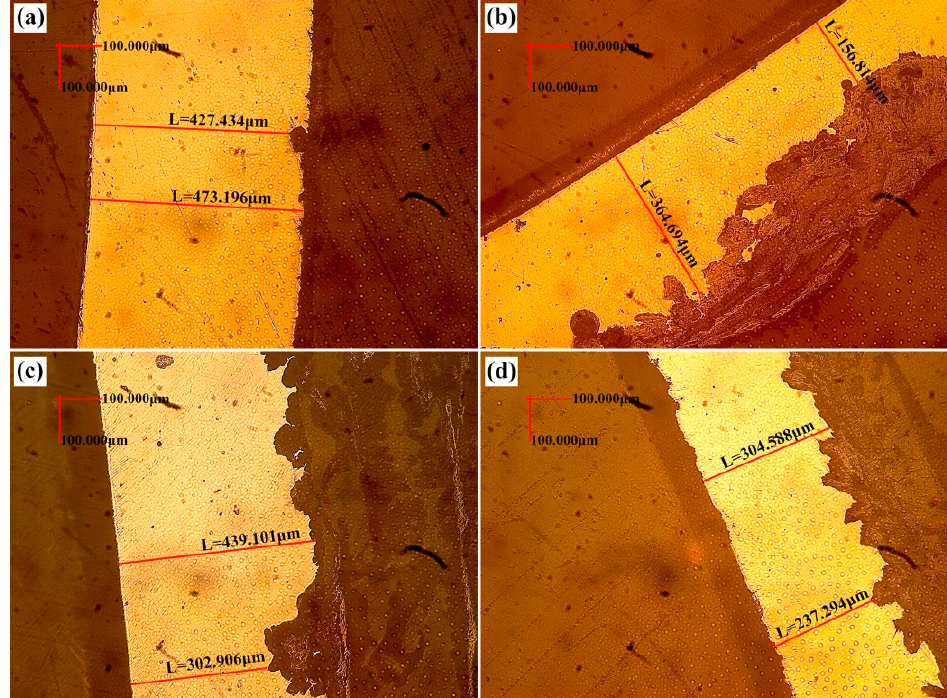
Figure 12. Residual thickness measurement on the cross-section of the sensors after being exposed for 3 months in the marine atmospheric zone ( a ), the splash zone ( b ), the tidal zone ( c ), and the immersion zone ( d ), respectively.